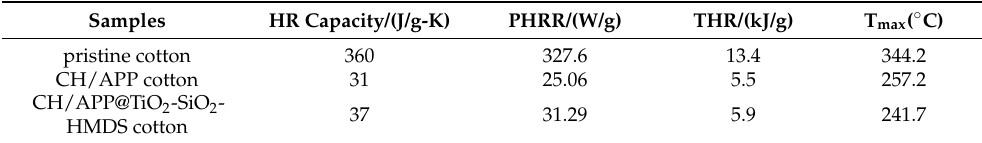
Figure 5. HRR curves of pristine cotton, CH/APP cotton, and CH/APP@TiO 2 -SiO 2 -HMDS cotton samples from MCC. Table 3. Microscale combustion calorimeter results for various samples.